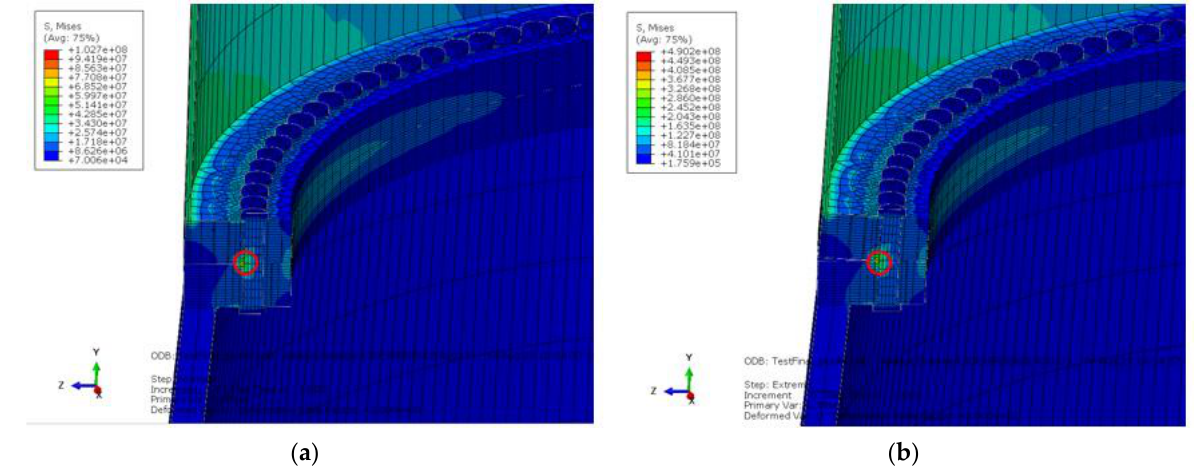
Figure 19. Von Mises stresses: ( a ) Normal conditions, ( b ) Extreme sea conditions.